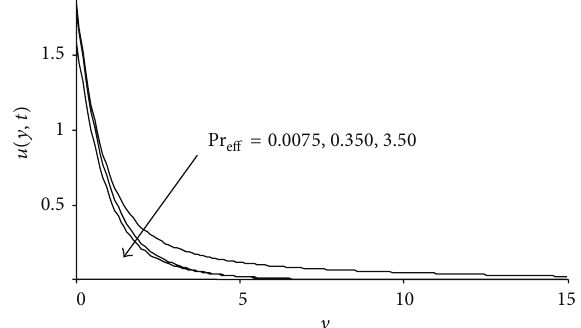
Figure 11: Concentration profiles for 𝑡 = 1 . 2 and different values of